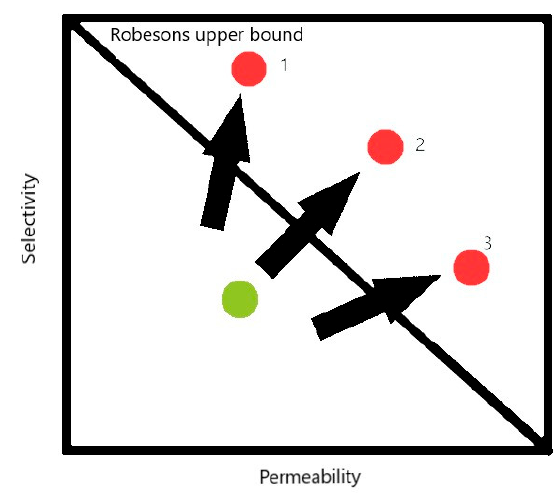
Figure 3. Three cases of possible changes of MMMs transport parameters depending on the modi- fier.